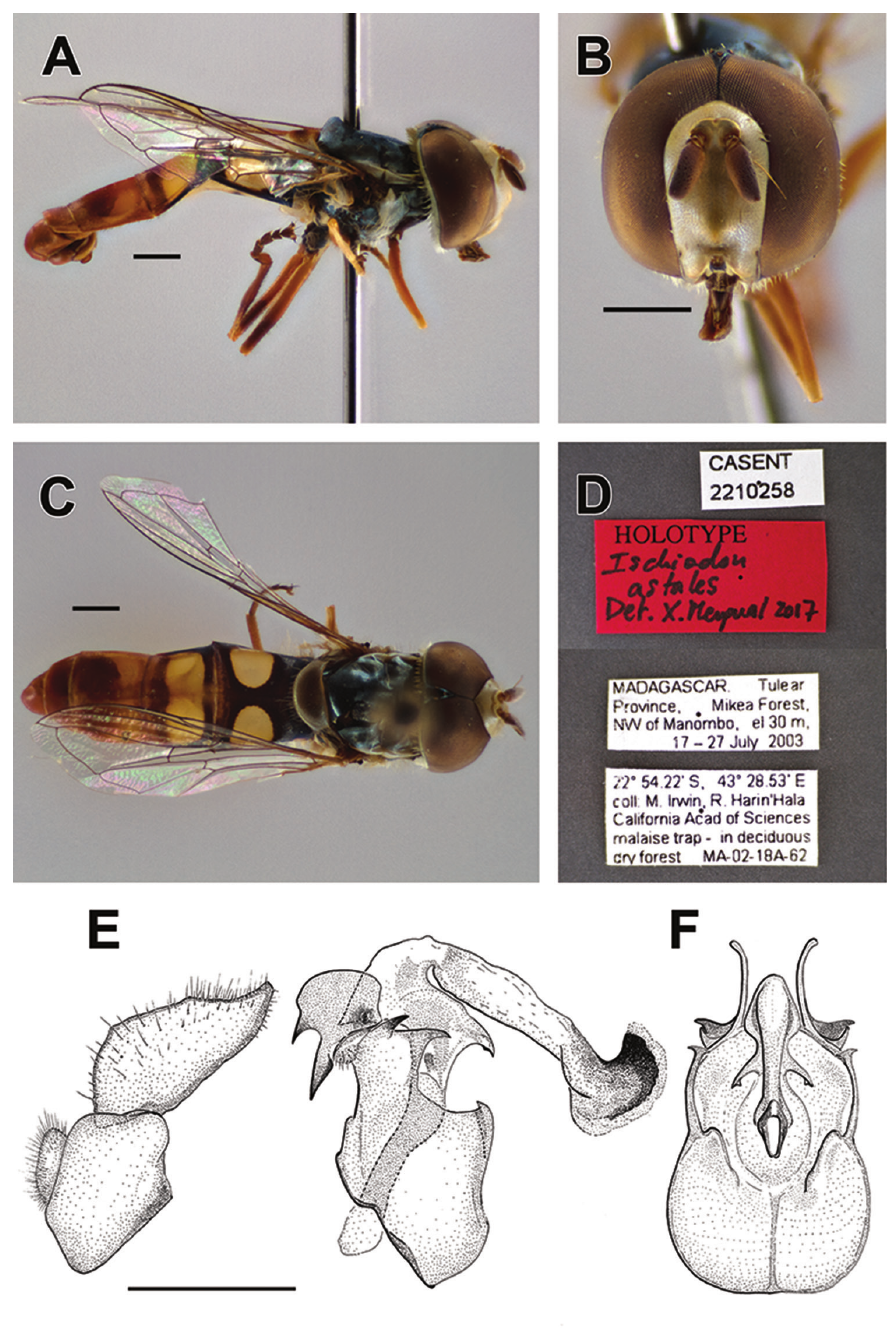
Figure 2. Ischiodon astales sp. n., male holotype CASENT 2210258: A Habitus, lateral view B Frontal view C Habitus, dorsal view D Labels E Male genitalia, lateral view F Hypandrium, ventral view. Scale bars: 1